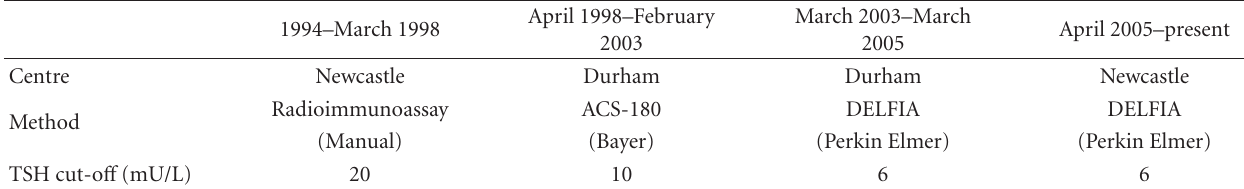
Table 1: TSH newborn screening base, assay methodology, and cut-o ff values during the study period.